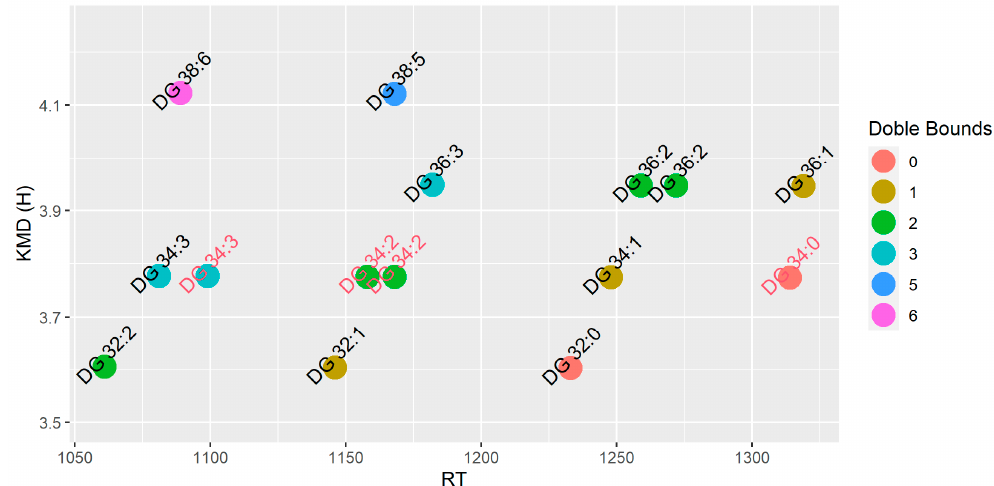
Figure 1. Kendricks Mass Defect calculated by the hydrogen base for diacylglycerols tentatively identified by the lipidomics approach. Metabolites were colored by doble bounds. Compounds name without MS/MS experiments were colored in red.